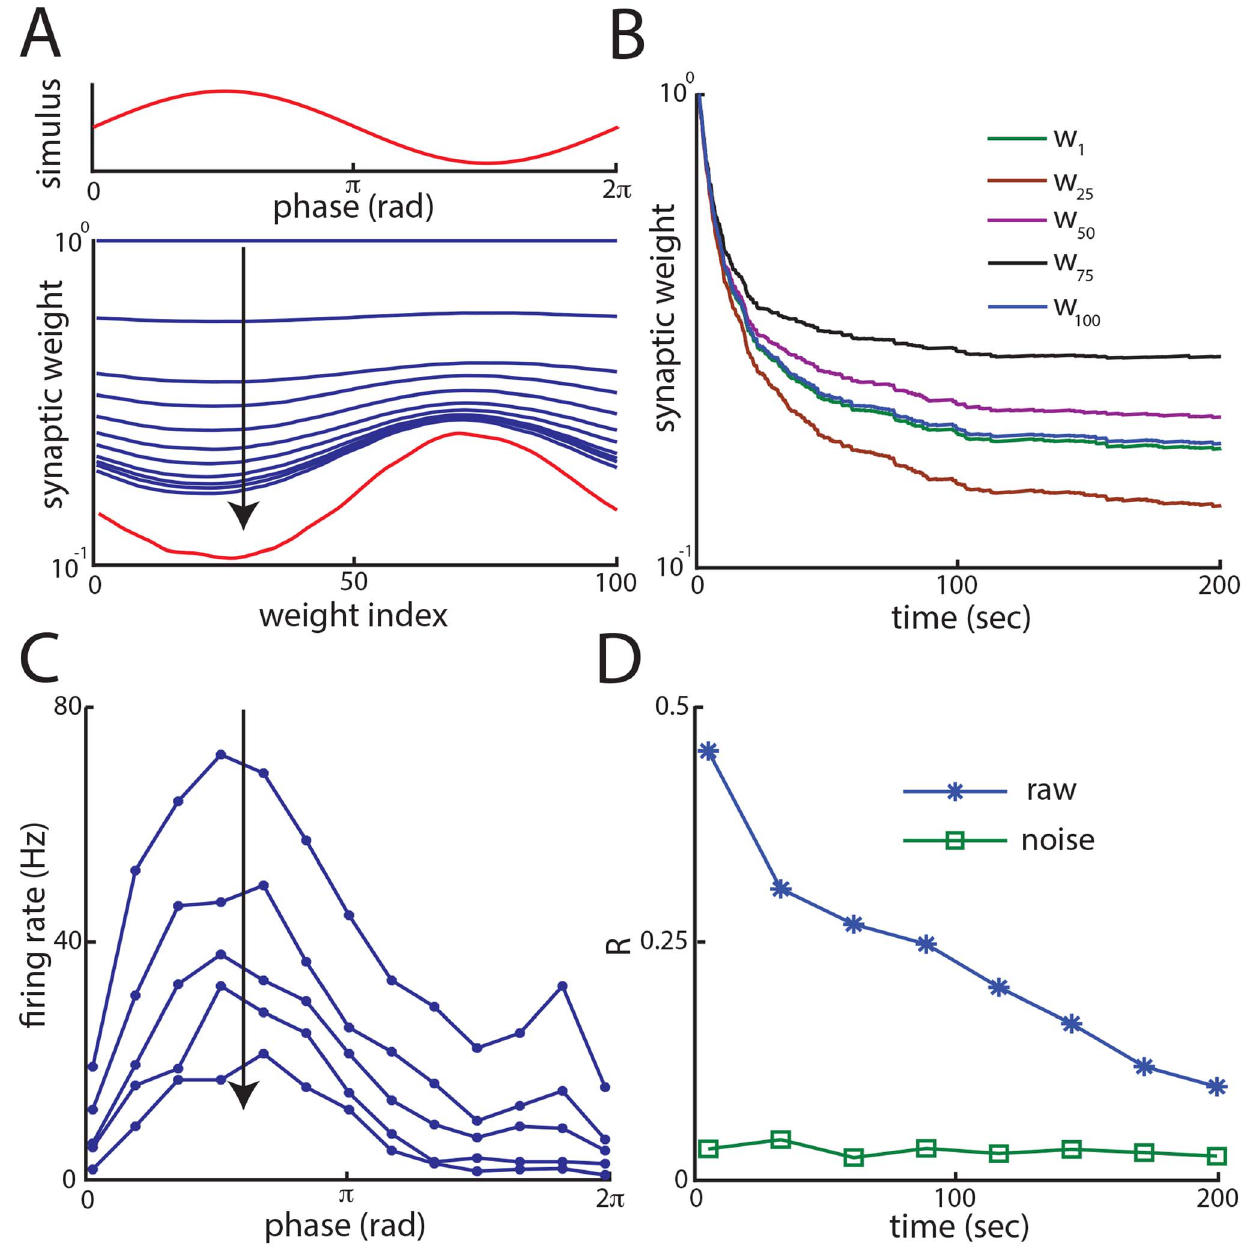
Fig. 3. The formation of a negative image mediated by anti-Hebbian burst time dependent plasticity reduces signal but not noise correlations. A ) One cycle of the 4 Hz sinusoidal stimulus (top, red trace) and synaptic weights (bottom, blue traces) as a function of time for (black traces from top to bottom), t=0, t=0.5 sec, t=1 sec, t=1.5 sec, t=2 sec, t=2.5 sec, t=3 sec, t=3.5 sec, t=4 sec, t=4.5 sec, t=5 sec, t=5.5 sec. The red trace (bottom) shows the synaptic weights at t=1000 sec (steady state) for comparison. The vertical arrow shows the progression of time. B ) Time series of 5 synaptic weights during training. C ) Cycle histograms from one SP cell neuron for the synaptic weights corresponding to (from top to bottom): t=25 sec, 50 sec, 75 sec, 100 sec, 150 sec, and 200 sec. The vertical arrow shows the progression of time. Note the progressive reduction in response modulation as the negative image forms. D ) Raw and noise correlation computed for the synaptic weights values obtained during training for the same time shown on the x-axis. Note the progressive decrease in signal correlations but the relative constancy of noise